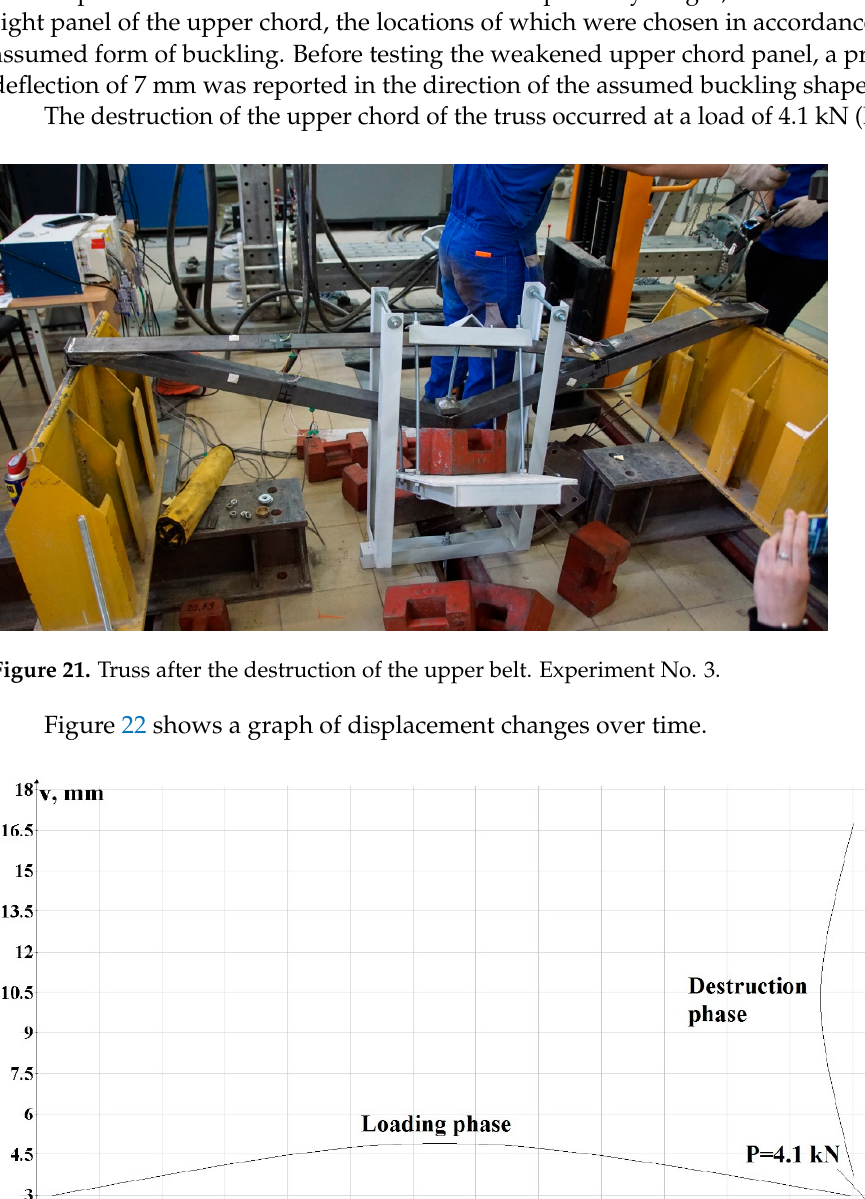
Figure 20. Change in the de fl ection of the truss, mm ( y -axis) in time, s ( x -axis) in the phase of de- struction of the lower belt (P = 4.85 kN). Experiment No. 2.